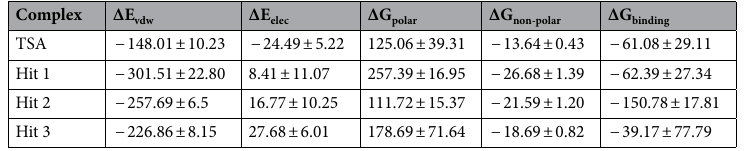
Table 6. The binding free energy (kJ/mol) between the simulated complexes of TSA and screened hit compounds with HDAC3 was calculated by the MM-PBSA method. ∆ E vdw , ∆E ele , ∆G polar , ∆G non-polar and ∆G binding represented van der Waals energy, electrostatic energy, polar solvation energy, nonpolar solvation energy and binding energy, respectively.